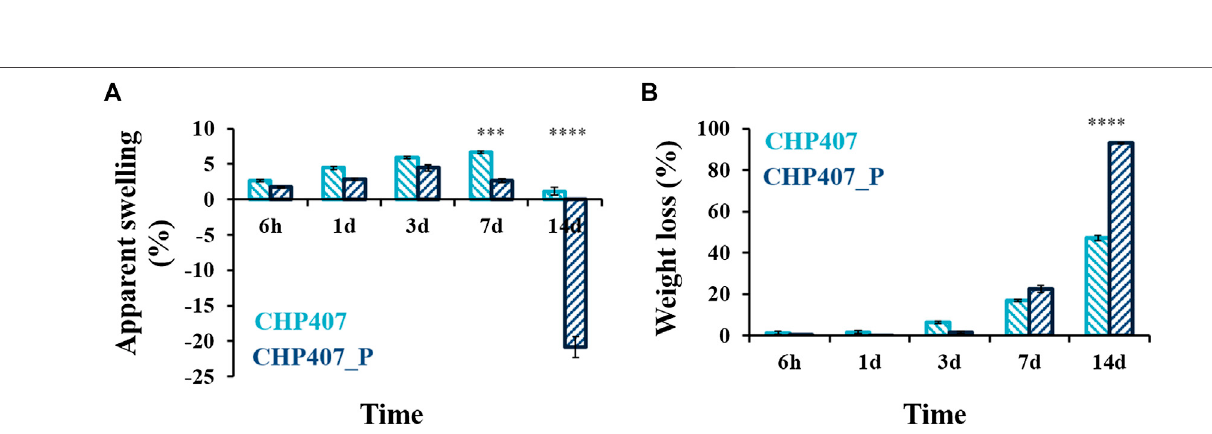
Frontiers in Materials |